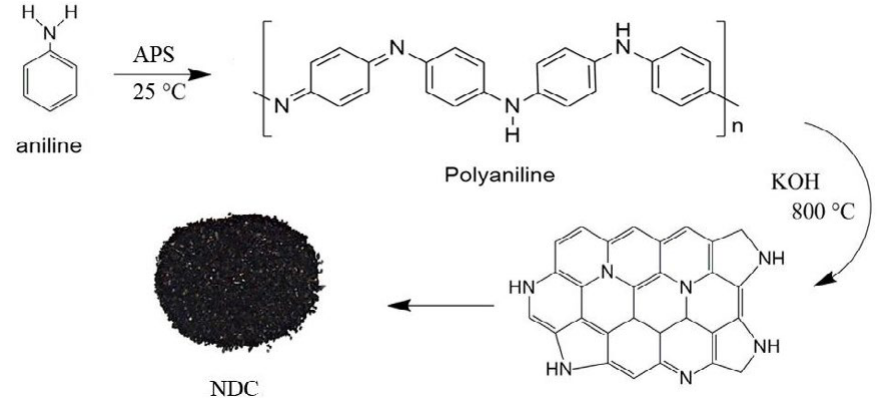
Fig. 1. Schematic illustration of the preparation of porous carbon (NDC).